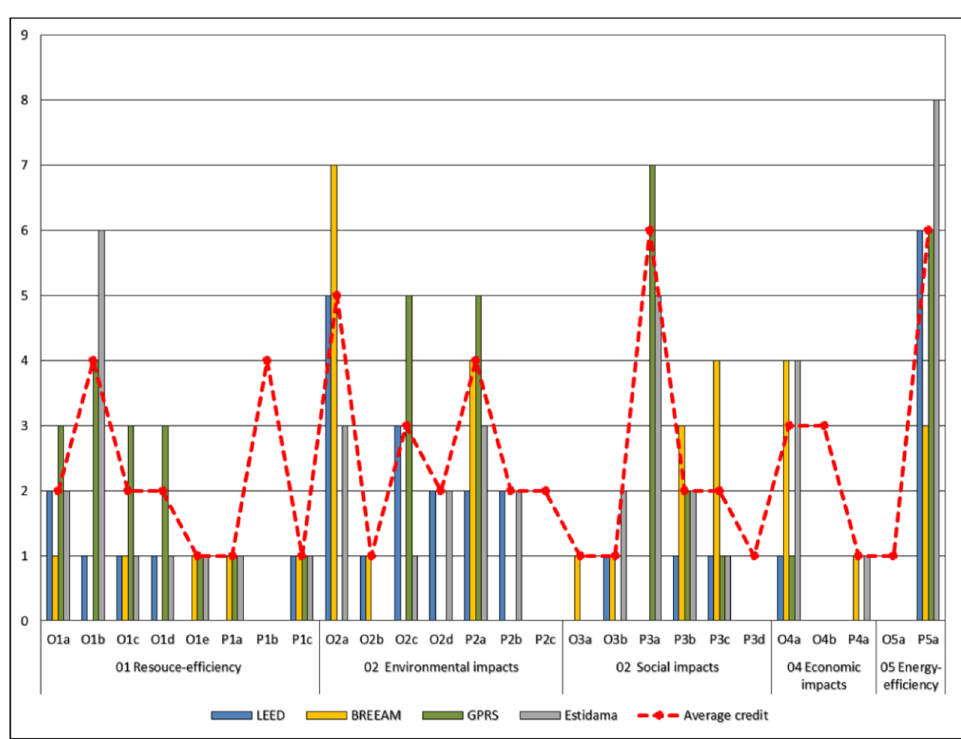
Figure 3. Sub-criteria ranking for green building rating systems and the proposed framework. The highest average credit points among all assessed sub-criteria in four green building rating systems are for the effect on energy consumption and thermal performance, as shown in Figure 3, followed by involving minimum levels of adverse impacts. The same for Estidama is for the sub-criteria of “recycled content”. As for BREEAM, the highest highest credit for thermal